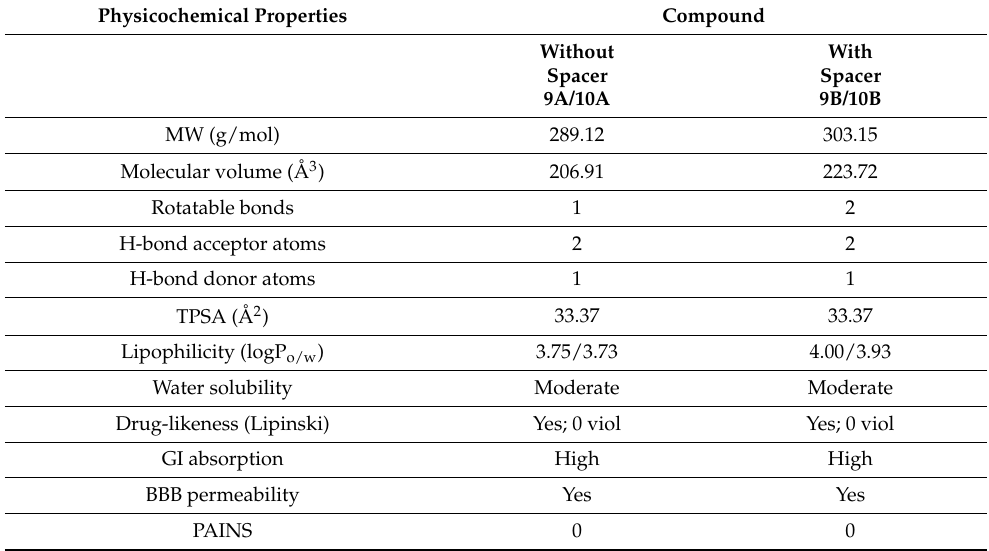
Figure 1. Protein-ligand interaction picture. ( A ) The binding site of compounds 9A and 9B ; and in ( B ) for compounds 10A and 10B . The key interacting residues are shown in ball-and-stick representation. Table 3. Molecular properties of 9A / 10A and 9B / 10B were calculated using the Swiss ADME software